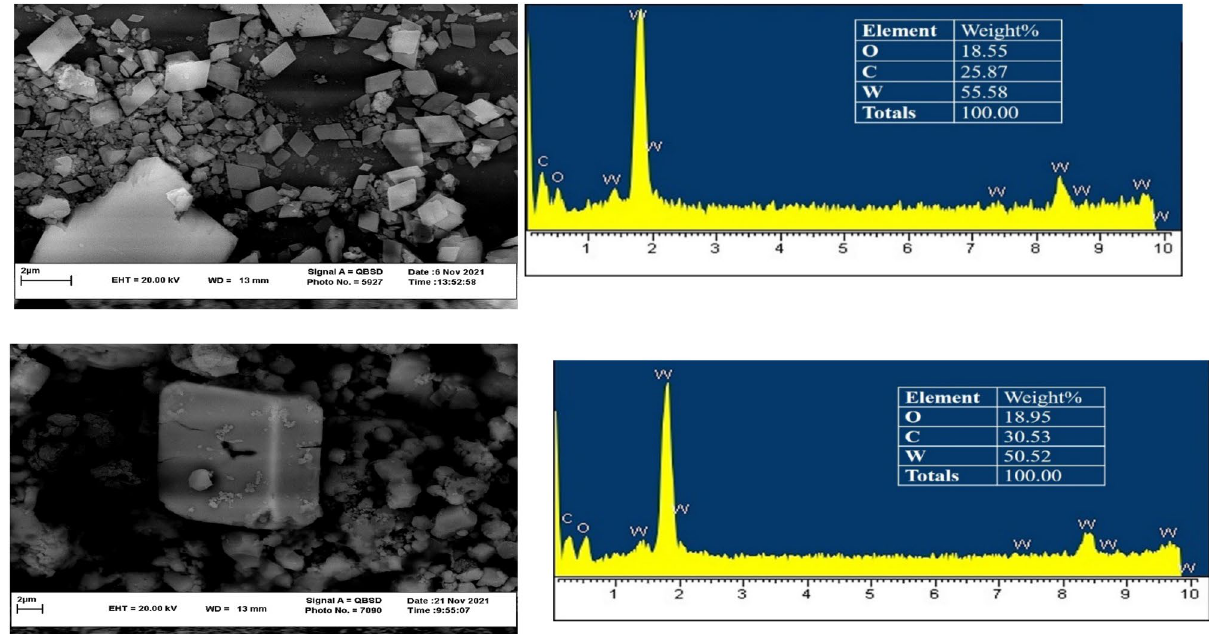
Figure 2. SEM images and EDS spectra of (up) TBA-PW 11 and (down) TBA-SiW 11 nano-catalysts.